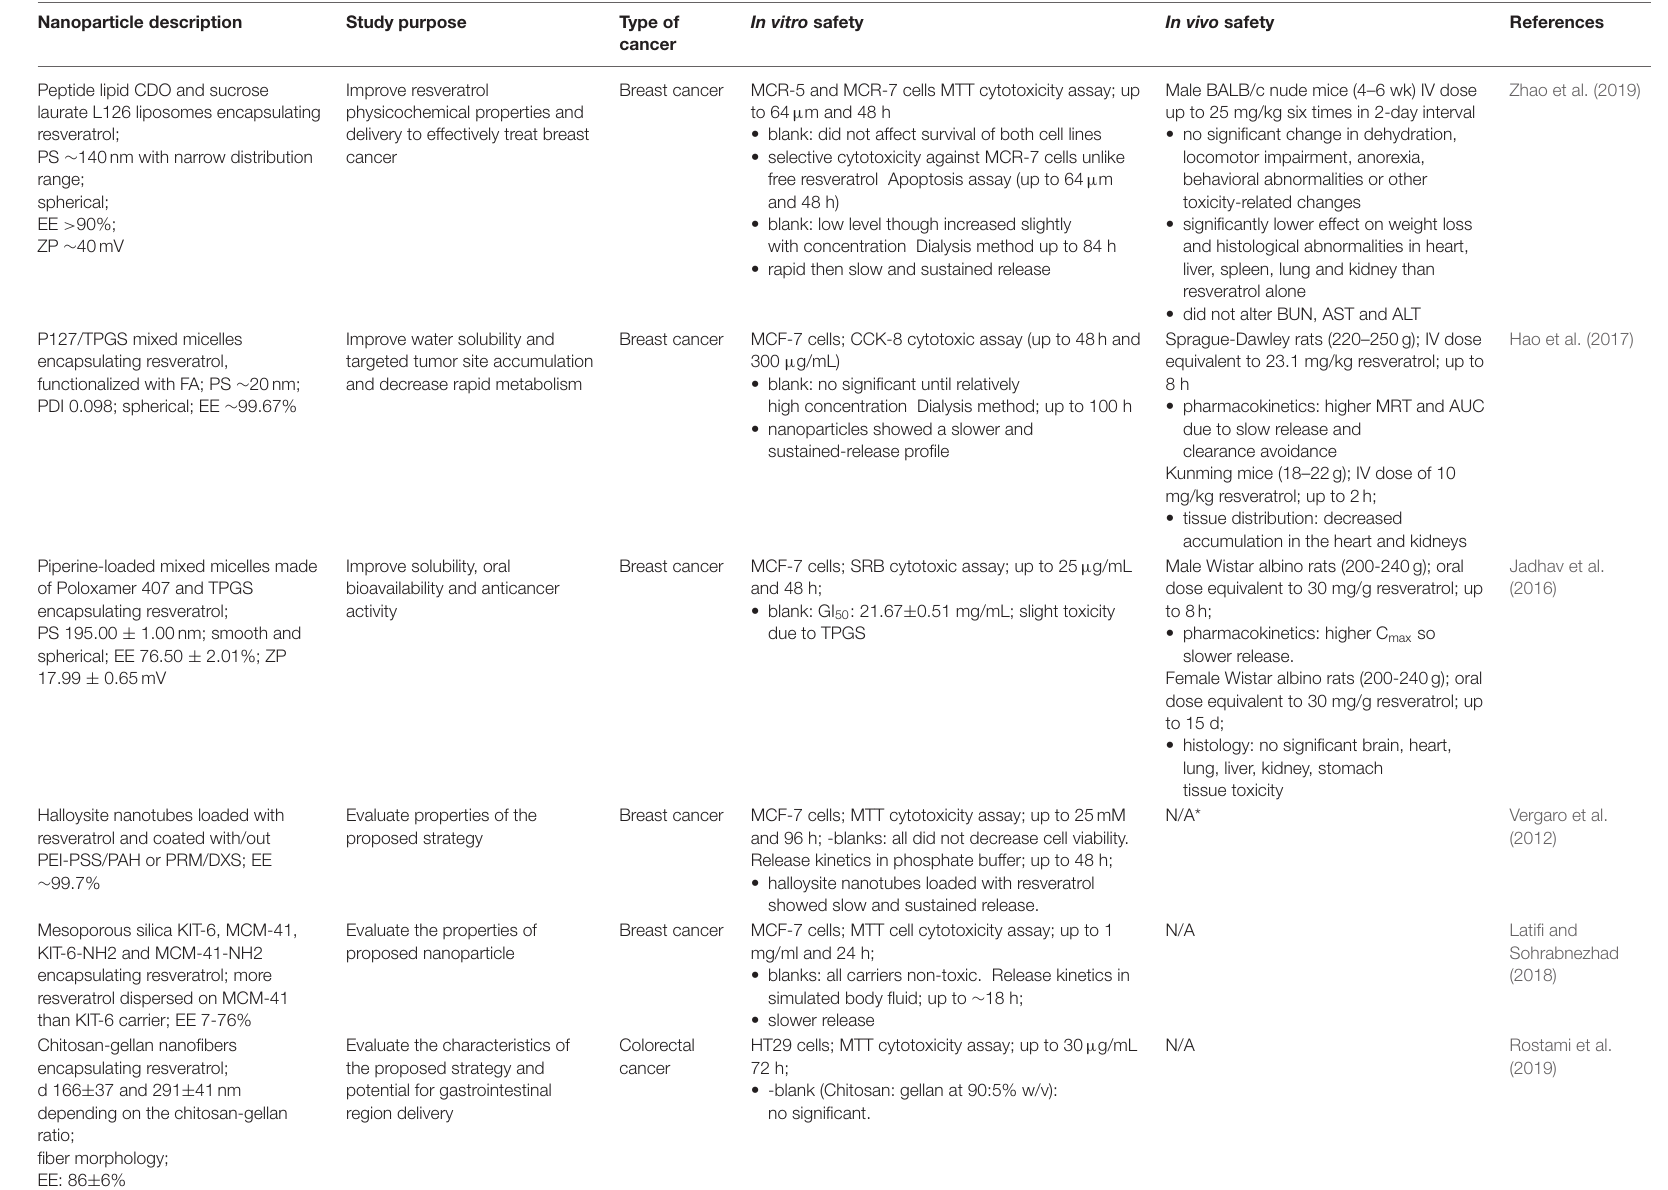
TABLE 2 | Nanoencapsulated resveratrol formulations and their relevant in vitro and in vivo safety